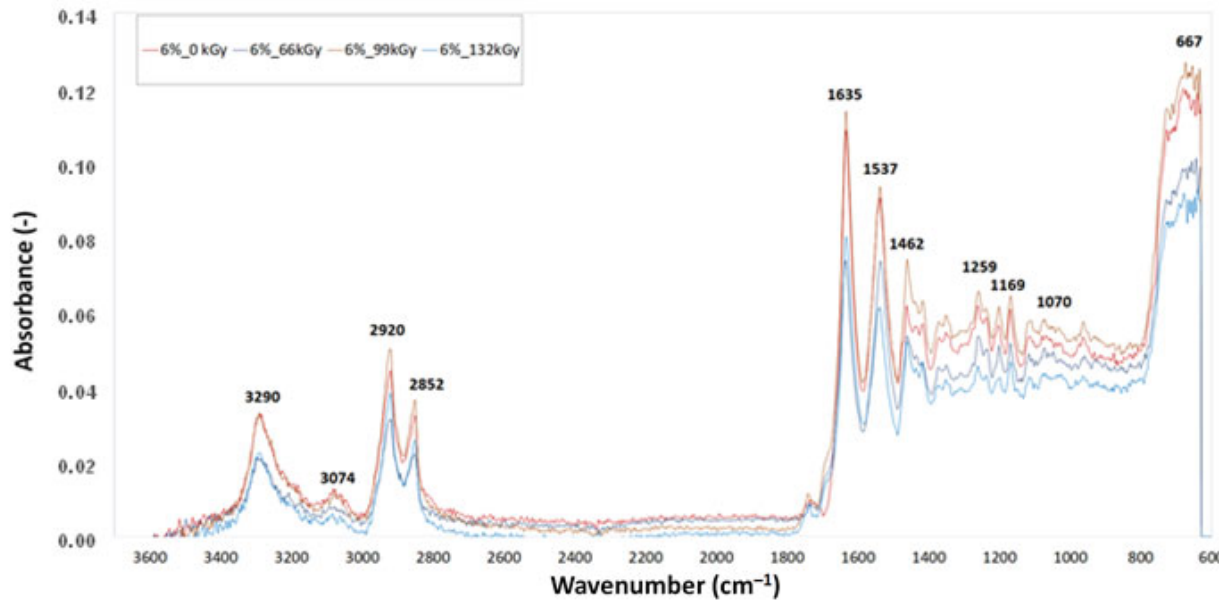
Figure 13. Fourier ‐ transform infrared spectroscopy of sample D. Figure 13. Fourier-transform infrared spectroscopy of sample D. Table 4. Values of absorbance at wavenumber 1736 cm − 1